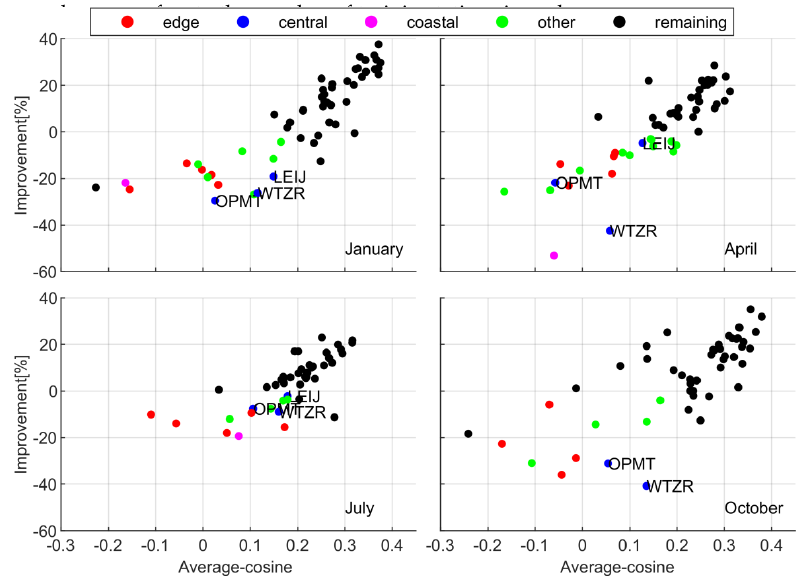
Figure 12. Similarity of the improvement rate with average-cosine value for each available station in January, April, July, and October of 2018. Among them, the black spots refer to the station with the improvement rate > 0 or |average cosine| > 0.2 . The red spots refer to the stations located in the edge region with the improvement rate < 0 and |average cosine| < 0.2 , the blue spots for the stations located in the central region, and the magenta spots for the stations close to the coast. For the red, blue, and magenta spots, their corresponding stations are included at least three months in January, April, July, and October of 2018. The other stations are presented by using the green spots. In Figure 12, we divide the available IGS station in January, April, July, and October of 2018 according to the station distribution, the improvement rate < 0 , as well as |average cosine| < 0.2 . When |average cosine| < 0.2 , the similarity of the training samples with the verified samples is weak. The overall trend between the average-cosine and the improvement rate tends to be linear from black spots, where the improvement rate in- creases with the rise of the average-cosine value. The average-cosine values of most sta- tions are more than 0.2 with a positive improvement rate. It implies that the overall accu- racy of estimated ZTD from Scheme 3 is superior to the accuracy of ERA5P-ZTD. Moreo- ver, the overall improved accuracy is associated with the similarity between training sta- tions and testing stations.